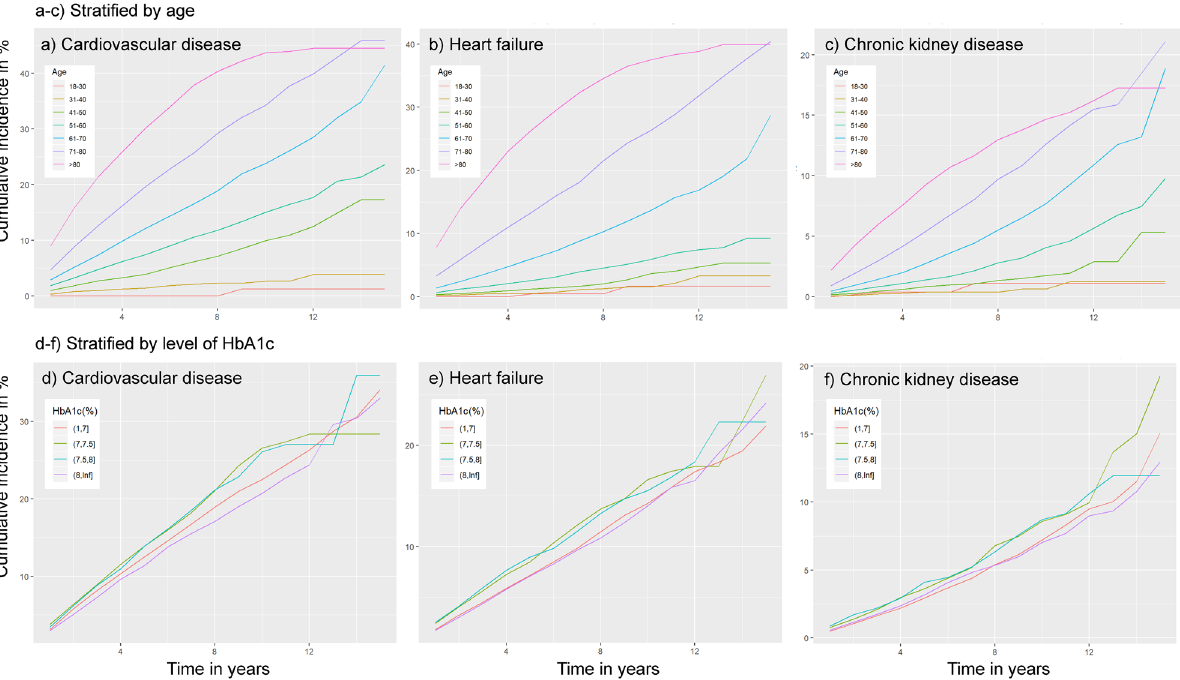
Figure 1. Cumulative incidence of complications. Line plots illustrating cumulative incidence (CI) (%) stratified by age ( A – C ) or HbA1c levels ( D – F ) at the time of diagnosis for cardiovascular disease (CVD), heart failure (HF), and chronic kidney disease (CKD). CI is presented on the y-axis and time from diagnosis on the x-axis (years). Note different scales on Y